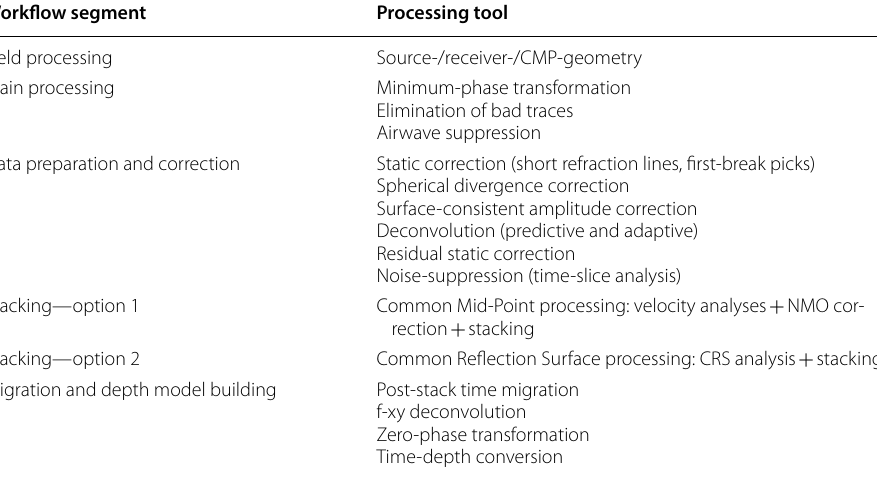
Table 2 Processing sequence applied to 3‑D seismic data volume in Groß